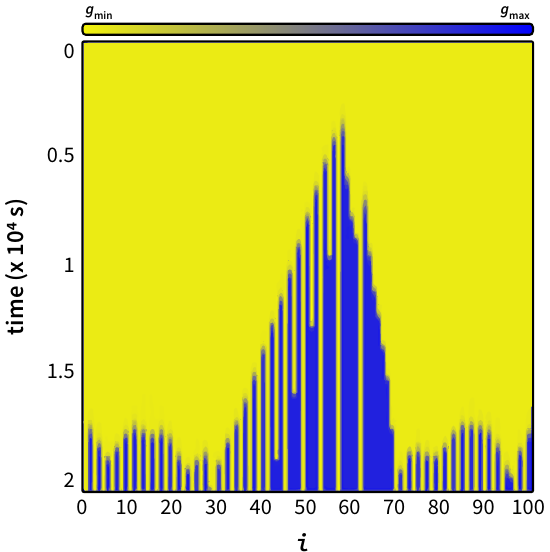
Figure 6. Space and time evolution of the conductance g of a 1-D excitable substrate with memristors, given a cyclic condition for the